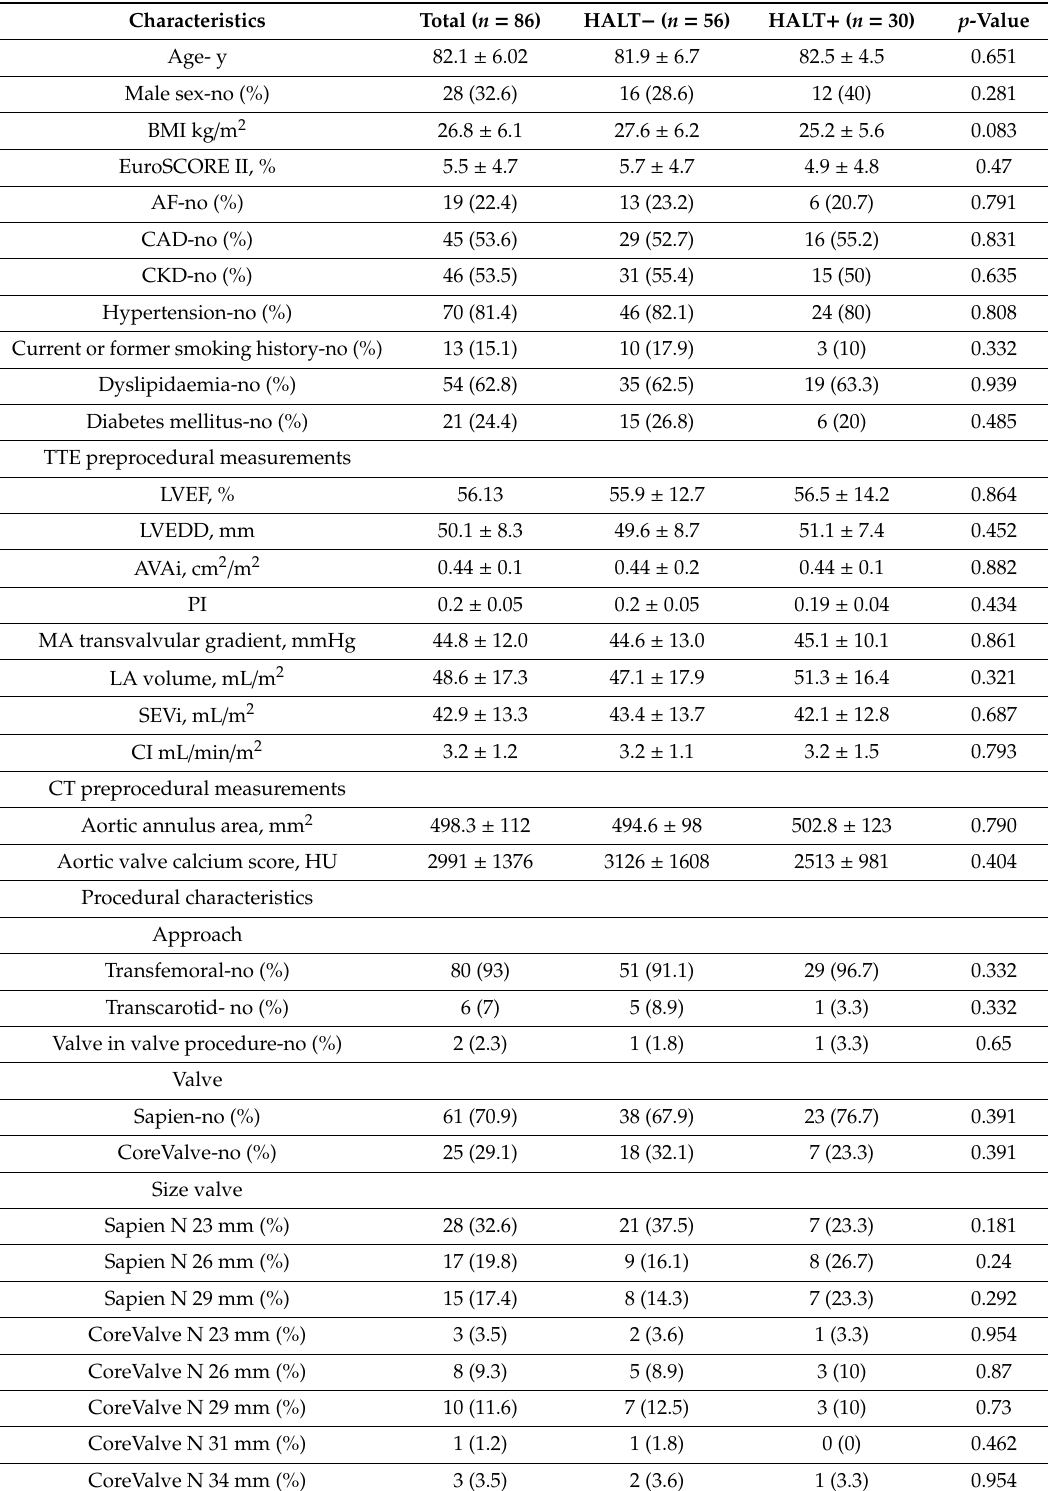
Table 6. Clinical baseline, echocardiographic, biological, and procedural characteristics for HALT.